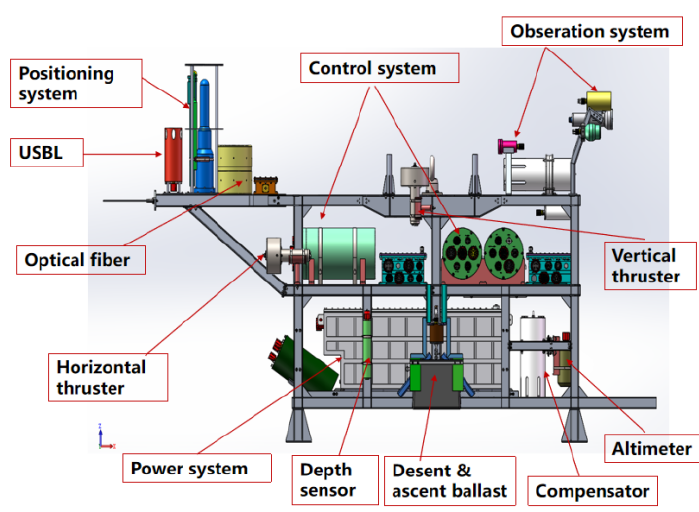
Figure 3. Schematic diagram of the 3D model of the submersible.